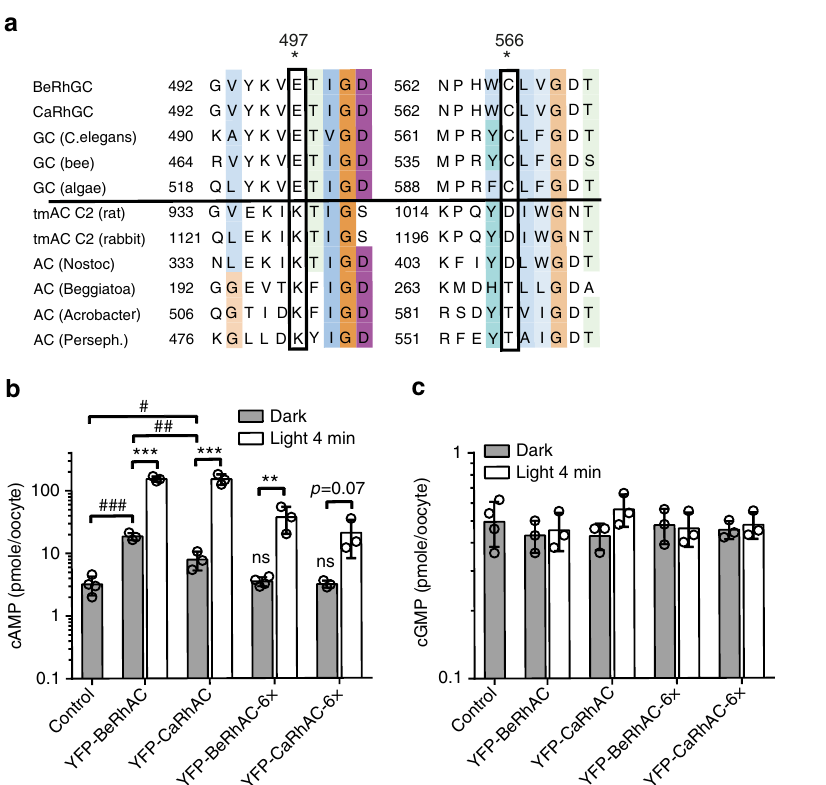
Fig. 5 Generation and characterization of adenylyl cyclases. a Sequence alignment of adenylyl cyclases (ACs) and guanylyl cyclases (GCs) from various organisms (full alignment and accession numbers in Supplementary Figure 6) shows key residues (*), involved in nucleotide binding, which differ between ACs and GCs. Insertion of the double mutation E497K, C566D-generated Ca/BeRhACs. Four additional mutations (564-QYDIW-568) were inserted in Ca/BeRhACs-6×. Enzymatic speci fi cities of the RhACs were determined via ELISA-based quanti fi cation of cAMP ( b ) and cGMP ( c ) within oocytes, expressing the N-terminal YFP-tagged constructs as indicated. Oocytes were kept in the dark or illuminated (light 4 min, 532 nm, 0.3 mWmm − 2 ) immediately before lysis. Bar graphs show data as means ± s.d., n = 3 samples of 5 oocytes each, *** p = 8 × 10 − 5 , 9 × 10 − 4 , ** p = 0.01, unpaired t -test light vs dark; ### p < 0.0001, ## p = 0.001, # p = 0.02, ns = not signi fi cant from control one-way ANOVA (dark conditions p < 0.0001) followed by Tukey ’ s multiple comparisons, for clarity not all comparisions are shown. Control = non-injected Neurons expressing YFP-BeRhAC-6× or YFP-CaRhAC-6× fre- Supplementary Table 3, Supplementary Figs. 3d, 9b, d). Neurons quently had multiple nuclei and were dif fi cult to record from. expressing YFP-CaRhAC alone or together with CNG(cGMP) Hippocampal neurons expressing YFP-CaRhAC had normal had no or small photocurrents (Fig. 6e, f, Supplementary Table 3, morphology and membrane properties (Fig. 6a – c). The YFP Supplementary Fig. 9). As hippocampal neurons have endogen- fl uorescence appeared to be associated with the plasma ous hyperpolarization-activated and cyclic nucleotide-gated membrane and intracellular membranes (Fig. 6b). Green fl ashes channels (HCN) 21 , at least part of these residual currents are likely due to activation of endogenous channels by cAMP. The repeatedly evoked transient currents through the cAMP-sensitive cAMP induced photocurrents were light intensity-dependent channels. The rise and decay of the currents was slower than for with an EC 50 of 0.6 mW mm − 2 (Fig. 6g, h). As expected, all the the YFP-CaRhGC evoked currents in Fig. 2c (Fig. 6d, e (inset),